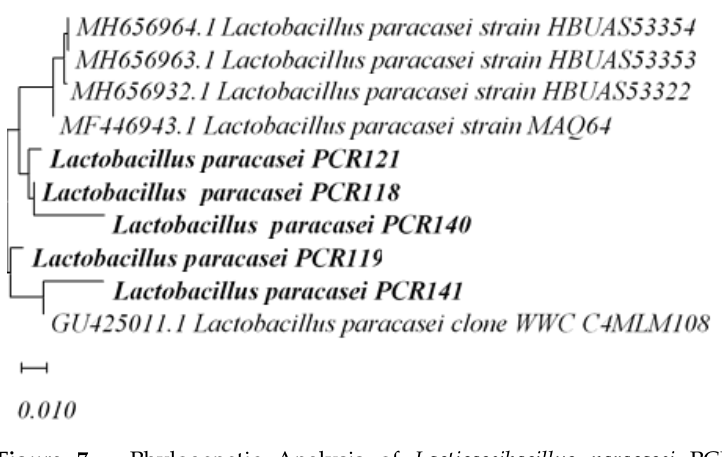
Figure 7. Phylogenetic Analysis of Lacticaseibacillus paracasei PCR121, PCR118, PCR140, PCR141,